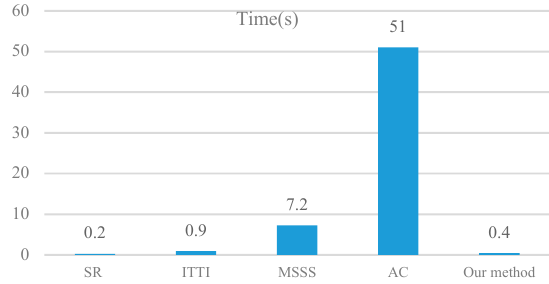
Figure 4. Comparison of saliency algorithm results. ( a ) Input image. ( b ) ITTI. ( c ) MSSS. ( d ) SR. ( e ) AC. ( f ) The proposed method.